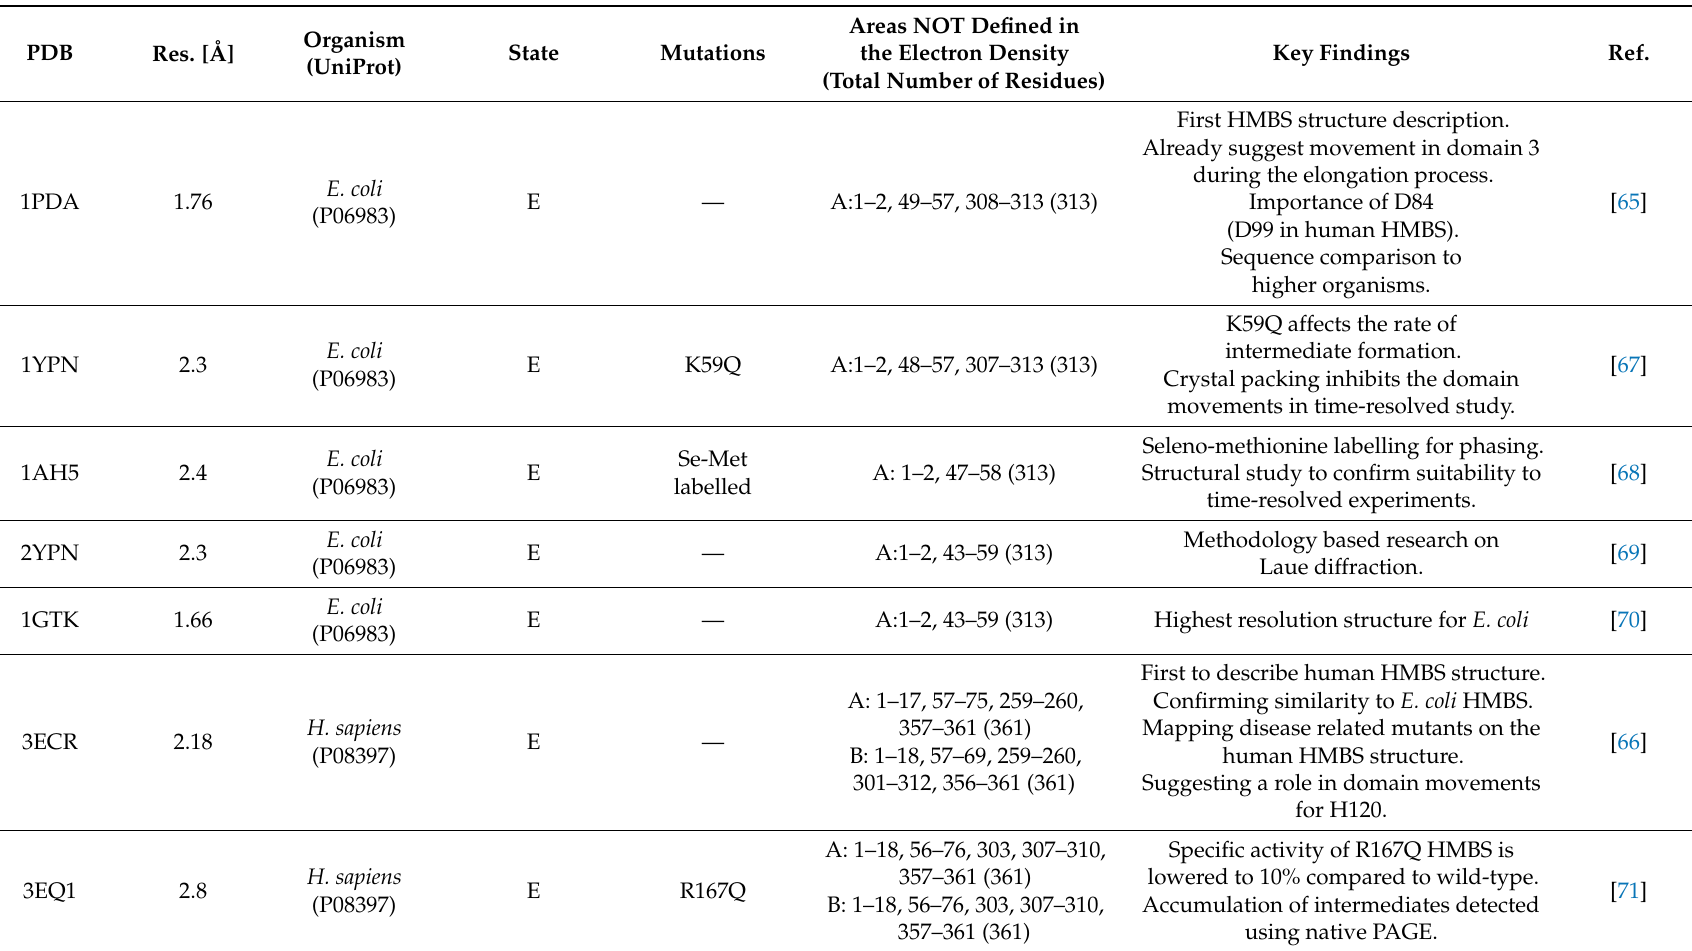
Table 1. Summary of the published crystal structures of HMBS enzyme from various organisms. Presenting the key structural aspects and highlights from the publications.